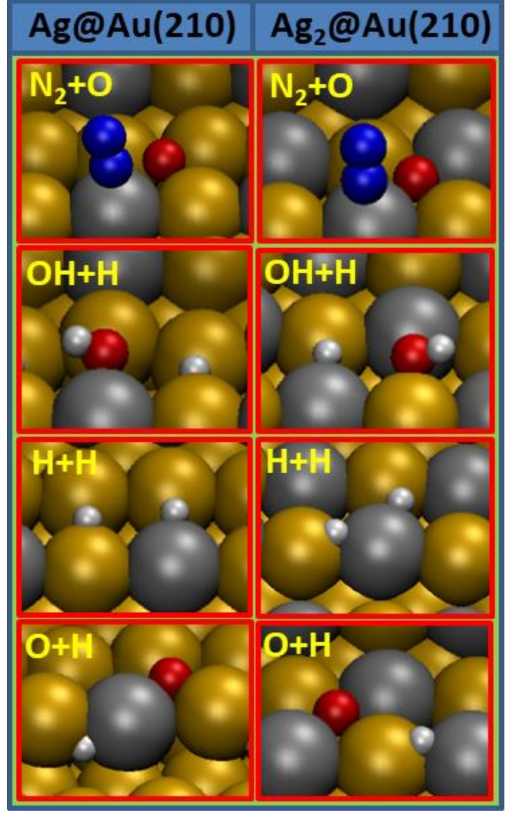
Figure 3. Most stable configurations for the coadsorption of pairs of species on Ag@Au(210) and Ag 2 @Au(210) surfaces which are involved in the N 2 O hydrogenation. Red color is used for oxygen, white for hydrogen, blue for nitrogen, grey for silver and ochre for gold